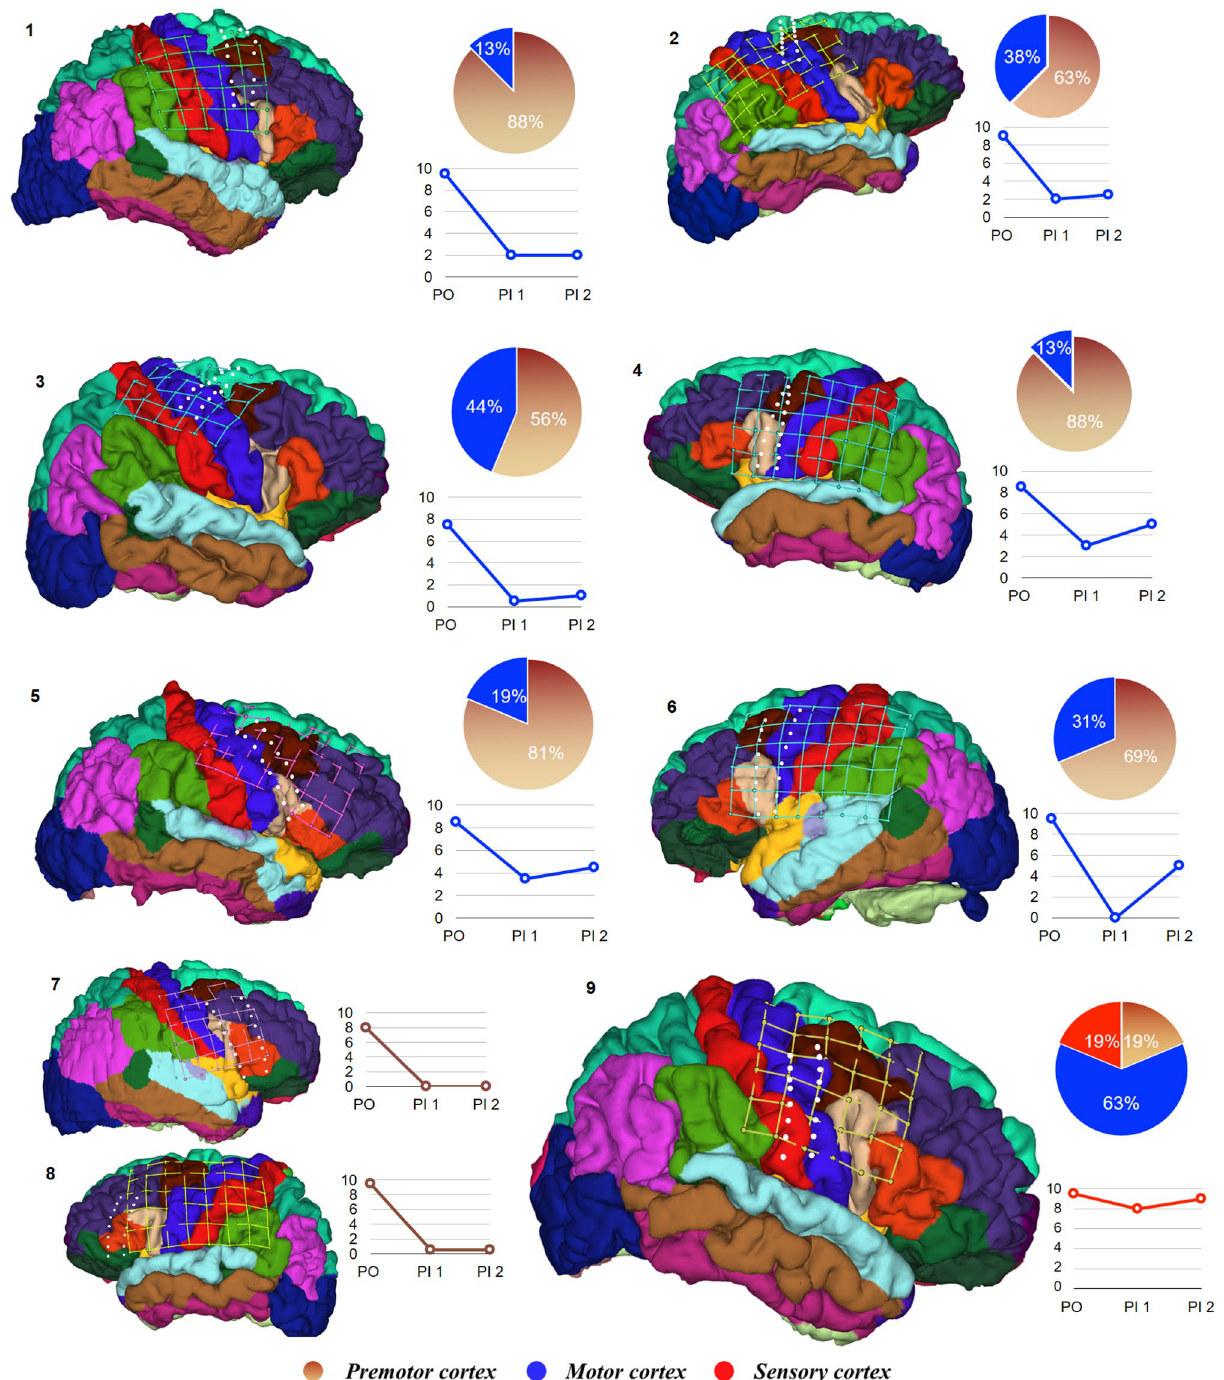
Figure 3 . Pain reduction effect of chronic subdural cortex stimulation. Reduction of pain with chronic subdural cortical stimulation presented here in three groups, based on electrodes location. 1st group: patients 1–6 with permanent grid implantation over both premotor and motor cortex; 2nd group: patients 7–8 with permanent grid implanted over premotor cortex; 3rd group: patient 9 for whom permanent grid implanted over motor, premotor and sensory cortex. Pie charts illustrate proportion of electrodes over particular cortex area. Line charts represent variation of pain level in patients after permanent grid implantation.